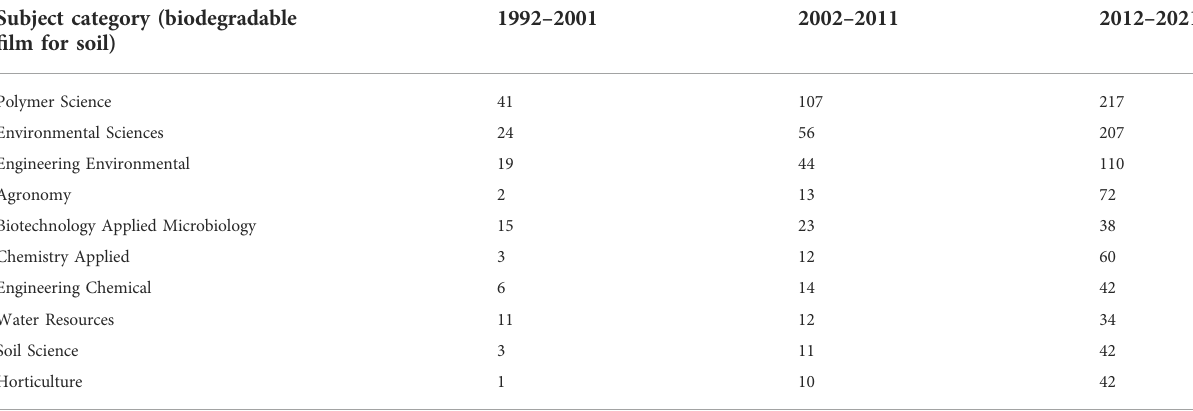
TABLE 1 Article output in ten subject categories for research on biodegradable fi lms for soil. Subject category (biodegradable fi lm for